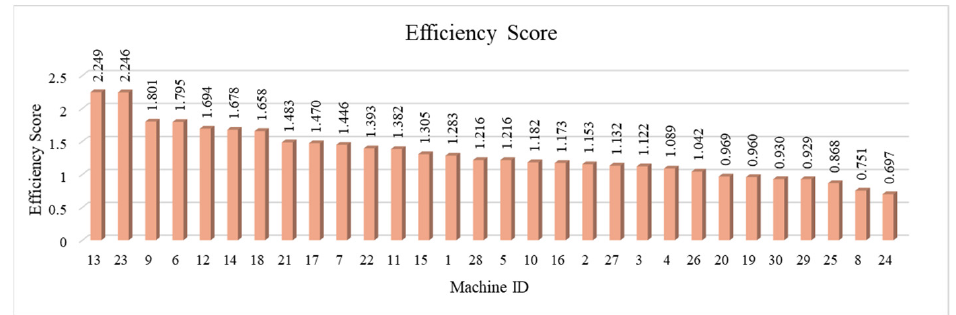
Figure 2. The e ffi ciency scores of machines. Figure 2. The efficiency scores of